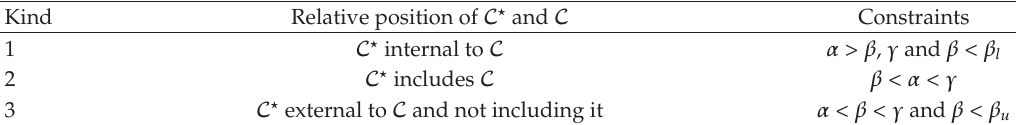
Table 1: Behaviour with respect to the first property, consequences on the position of the circle C (cid:9) (cid:7) ζ (cid:9) (cid:2) C (cid:3) , and corresponding constraints on α , β, and γ . The quantities β l and β u are defined in (cid:2) B.1 (cid:3) .